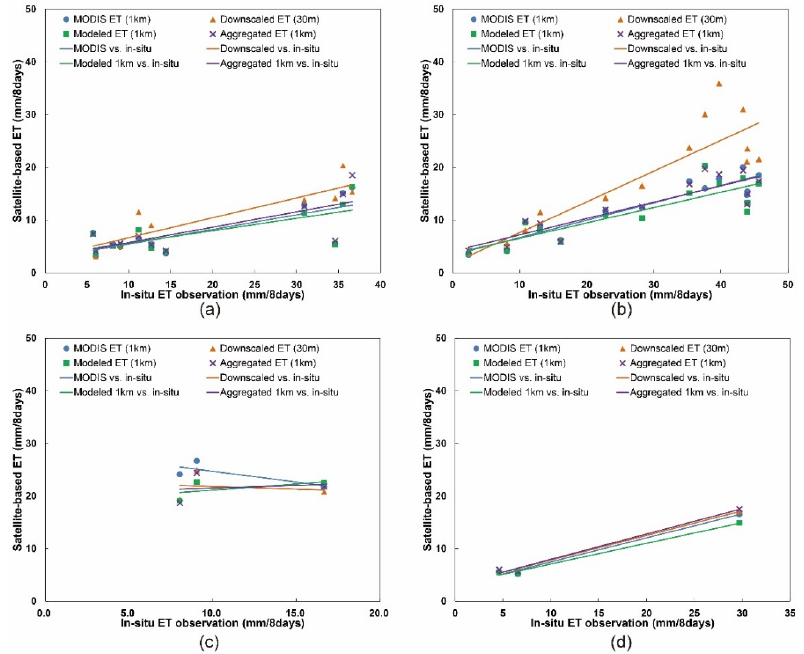
Figure 12. Scatterplots of satellite-based ET against in situ ET at: ( a ) Site 1; ( b ) Site 2; ( c ) Site 3; and ( d ) Site 4.